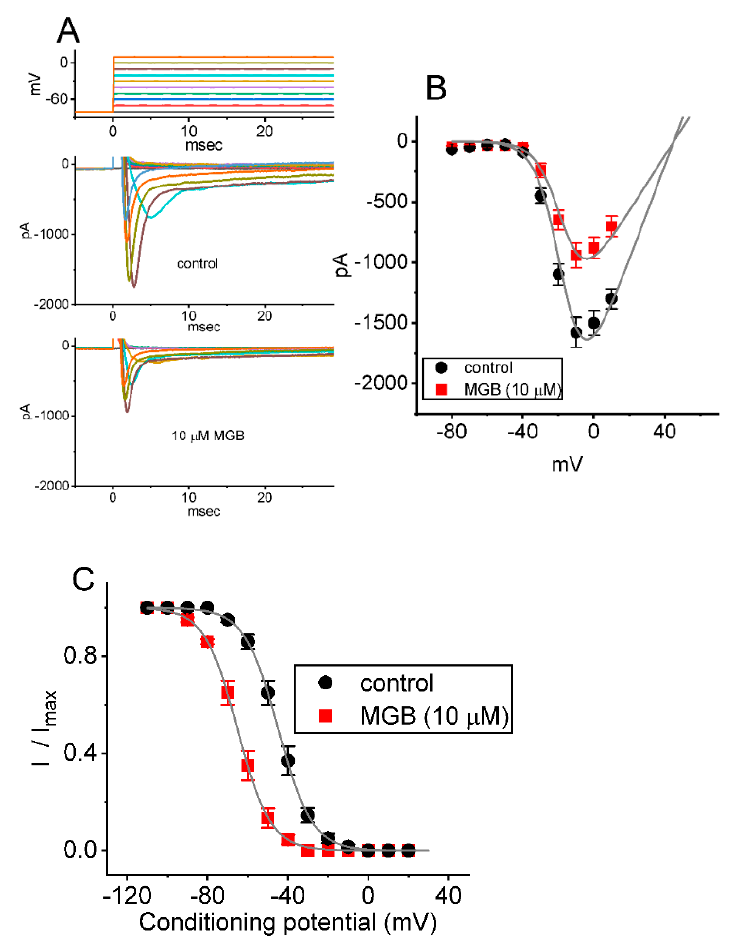
Figure 3. Mean current-voltage ( I-V ) relationship of I Na(T) in GH 3 cells. The preparations made during this series of experiments are the same as those described in Figures 1 and 2. The examined cell was maintained at − 80 mV and a series of depolarizing command voltages ranging from − 80 to +10 mV in 10 mV steps were applied to it. ( A ) Representative current traces taken in the control period (upper) and during cell exposure to 10 µ M MGB. The uppermost part shows the voltage protocol applied. ( B ) Mean I-V relationship of I Na(T) in the absence (filled black circles) and presence (filled red squares) of 10 µ M MGB (mean ± SEM; n = 7 for each point). Current amplitude was measured at the beginning of each depolarizing pulse. Of these, the overall I-V relationship of I Na(T) (or peak I Na ) seen in GH 3 cells was unaltered in the presence of MGB. ( C ) Quasi-steady-state inactivation curve of I Na(T) in the control (filled black circles) and during exposure to 10 µ M MGB (filled red squares) (mean ± SEM; n = 7 for each point). The Boltzmann equations for the I-V relation and inactivation curve of I Na(T) least squares fitted to generate the smooth lines are described in Materials and